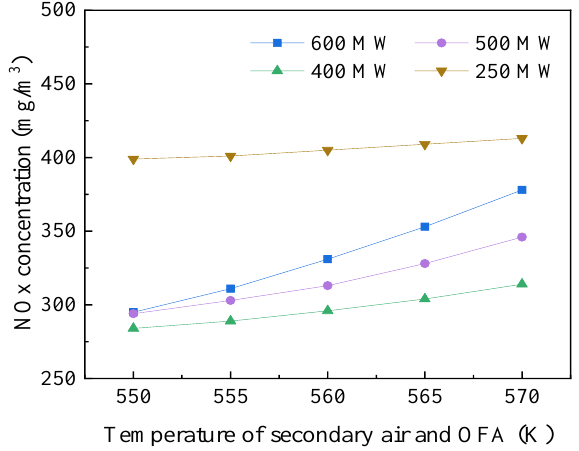
Figure 19. Variation in NOx concentration at economizer outlet with the temperature of secondary air and OFA.